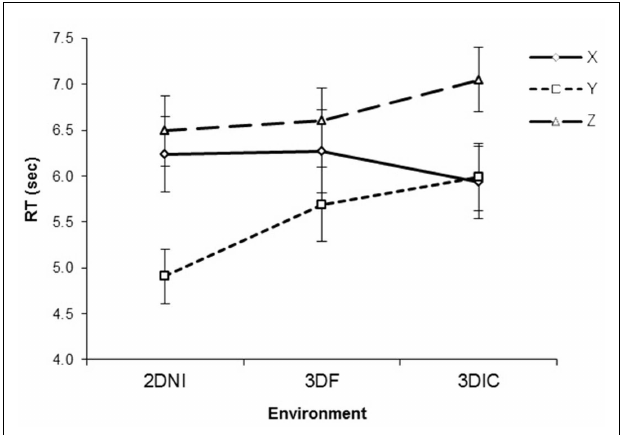
FIGURE 6 | Response time as a function of axis of rotation and viewing environment (2DNI, 3DIF, and 3DIC). Error bars represent standard error